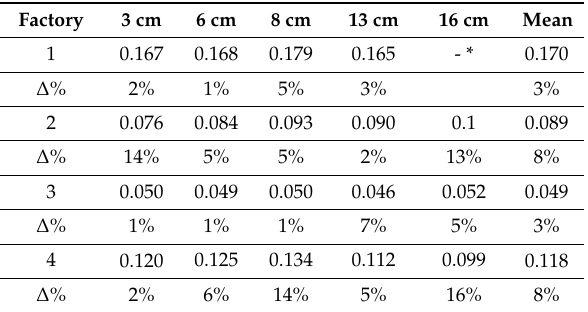
Figure 3. Thermal resistance as a function of the thickness variation of dry samples; ( a ) Dry-Extensive, ( b ) Dry-Intensive. Table 5. Dry thermal conductivity—extensive samples.